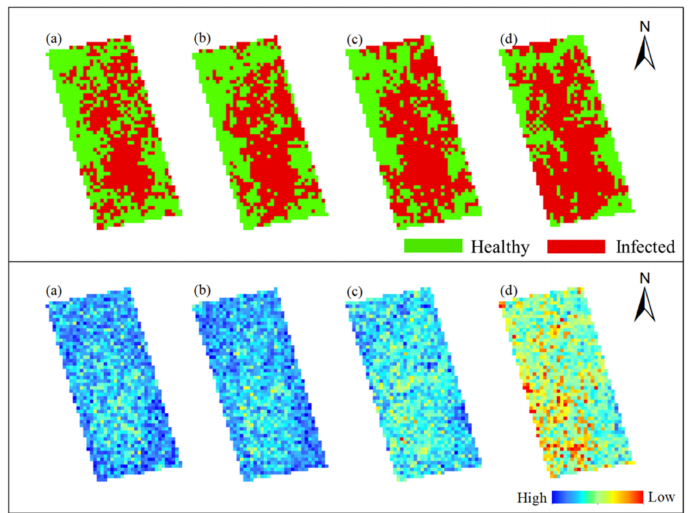
Figure 14. Spatiotemporal variation of occurrence area of rice false smut and corresponding SPAD values in Plot 1: ( a ) 14 August 2020; ( b ) 20 August 2020; ( c ) 25 August 2020; ( d ) 6 September